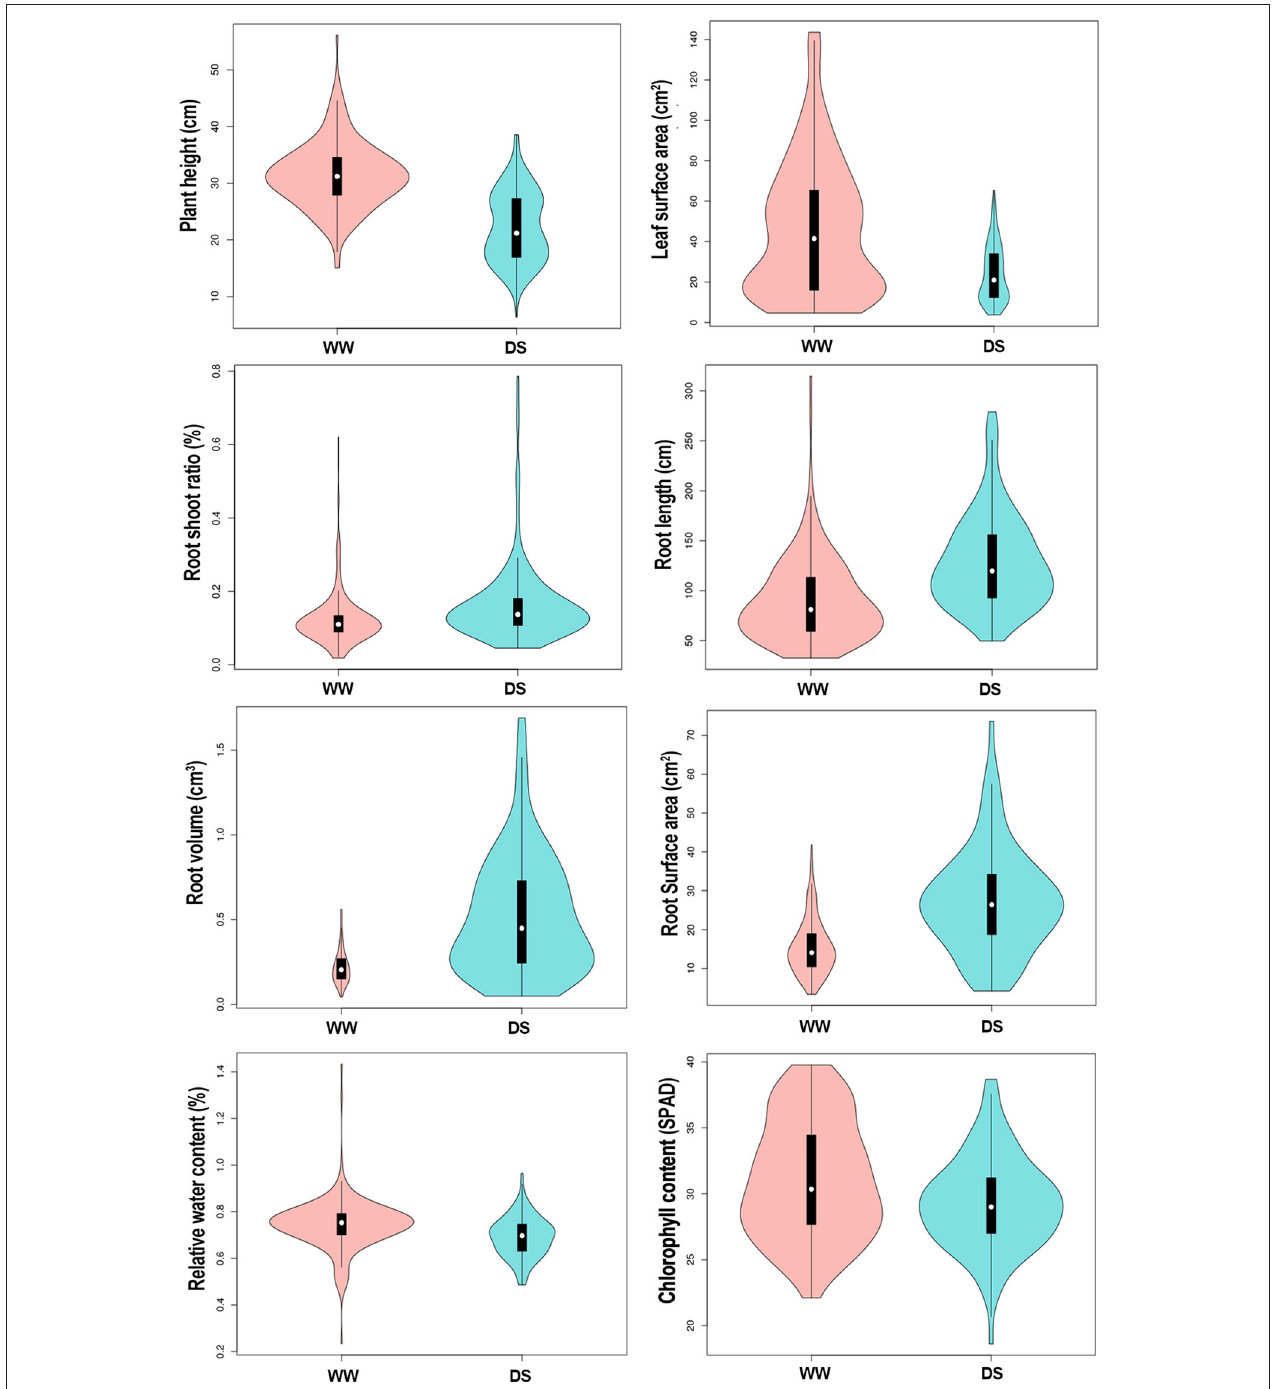
FIGURE 1 | Vioplot visualizing the 8 physiological traits of sunflower in response to different water treatments. Y -axis represent the density distribution of all 226 samples. WW, well-water growth condition; DS, drought-stress growth